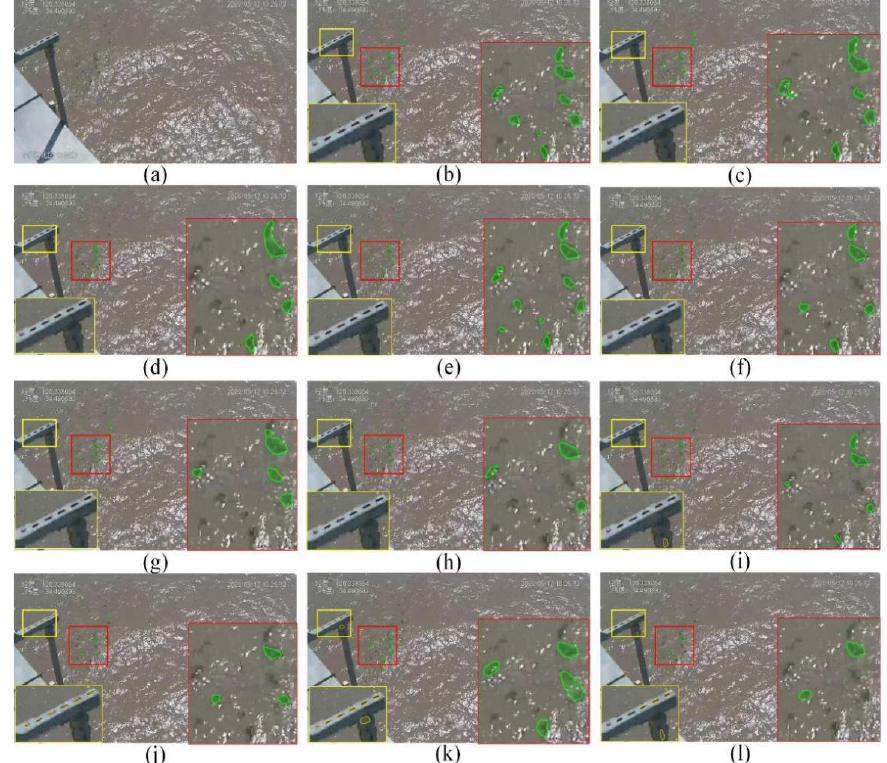
Figure 16. The visual comparison of results of different models in scene 3.